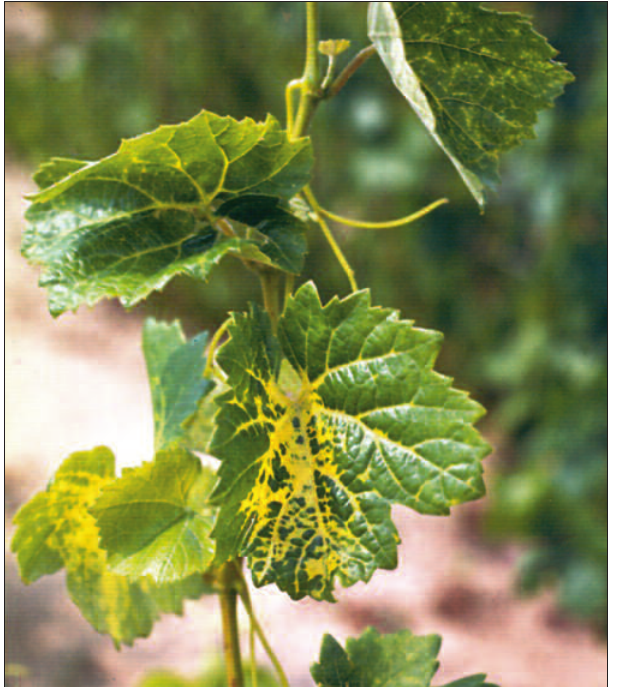
Figure 3. Arabis mosaic (ArMV) - tipical leaf-symptoms in Vitis vinifera cv. Hárslevelû